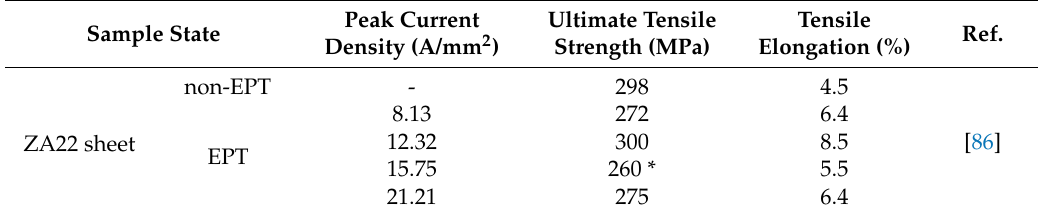
Table 2. Mechanical properties of zinc alloys before and after EPT.